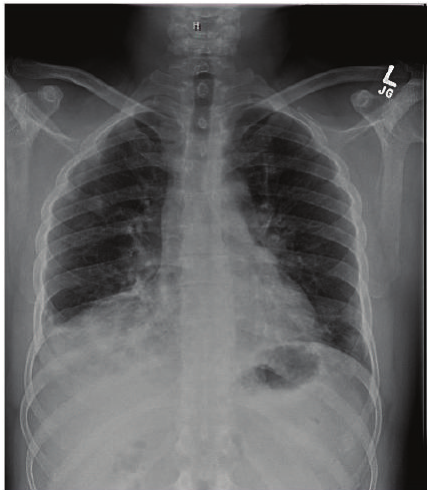
Figure 1: Chest X-ray showing bibasilar and right middle lobe infiltrate on presentation.